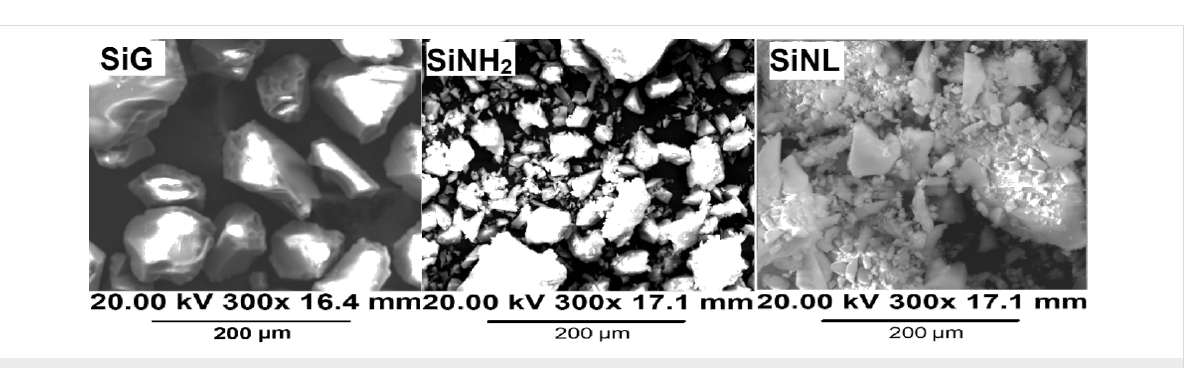
Figure 1: FTIR spectra of SiG, SiNH 2 and SiNL.